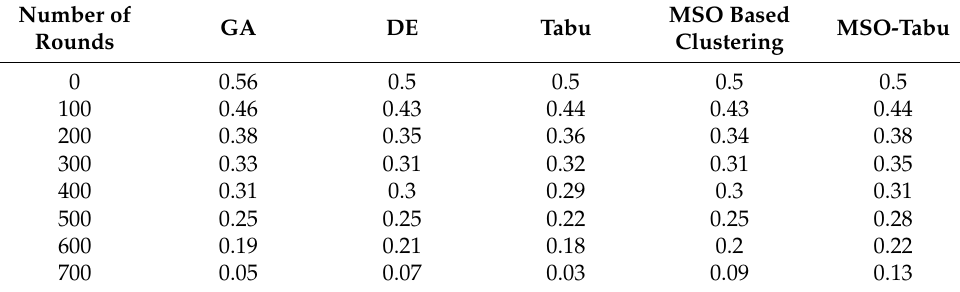
Table 6. Average energy dissipated in Joules for